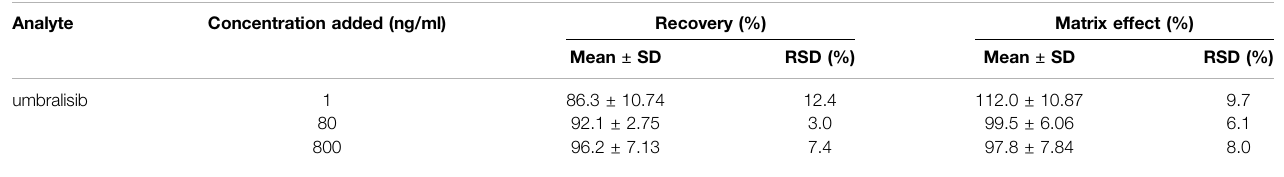
TABLE 3 | Recovery and matrix effect of umbralisib in rat plasma ( n (cid:1) 6). Analyte Concentration added